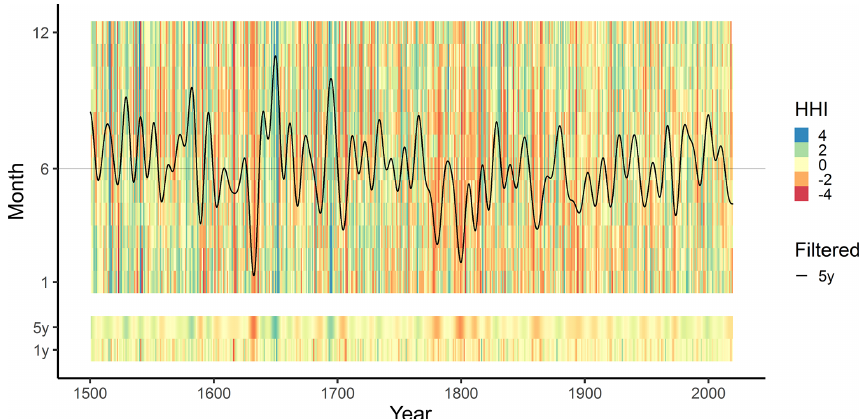
Figure 8. Historical humidity index (HHI) for Germany since 1500. The upper part represents the monthly HHI from January to December for each year and the overlaid 5-year low-pass filter (black line). The lower part indicates the low-pass values represented as colored scheme for 5 years and 1 year.